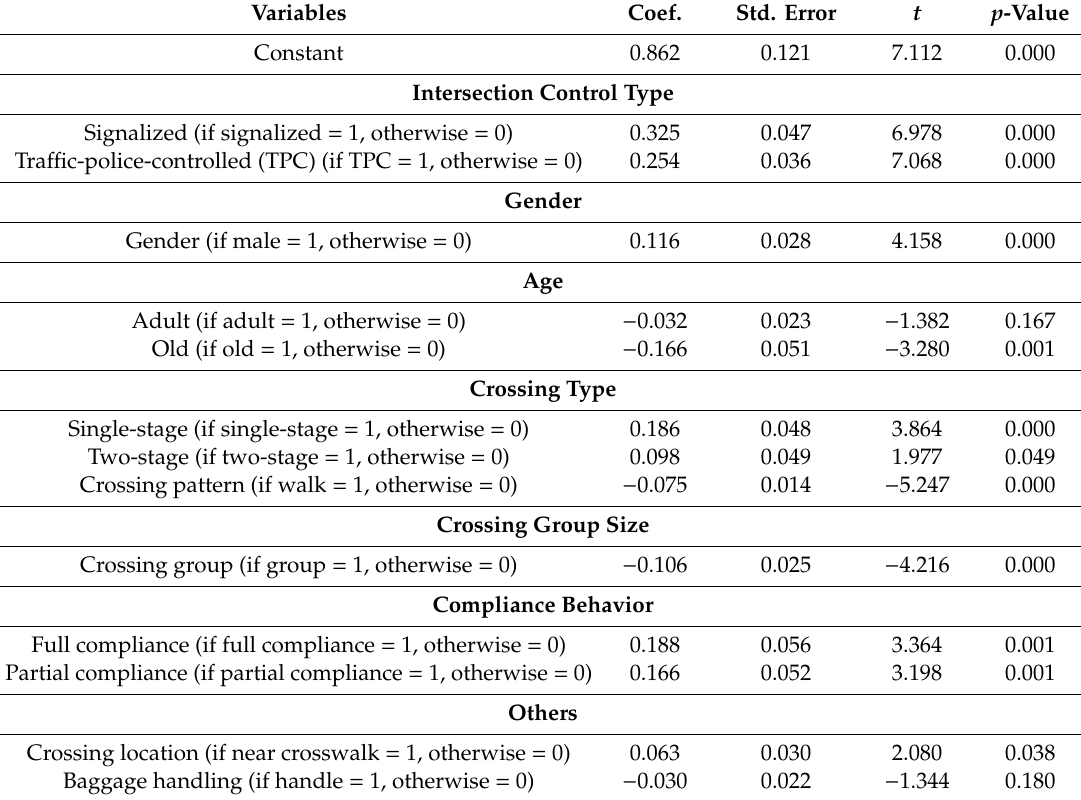
Table 6. Estimated parameter values of MLR